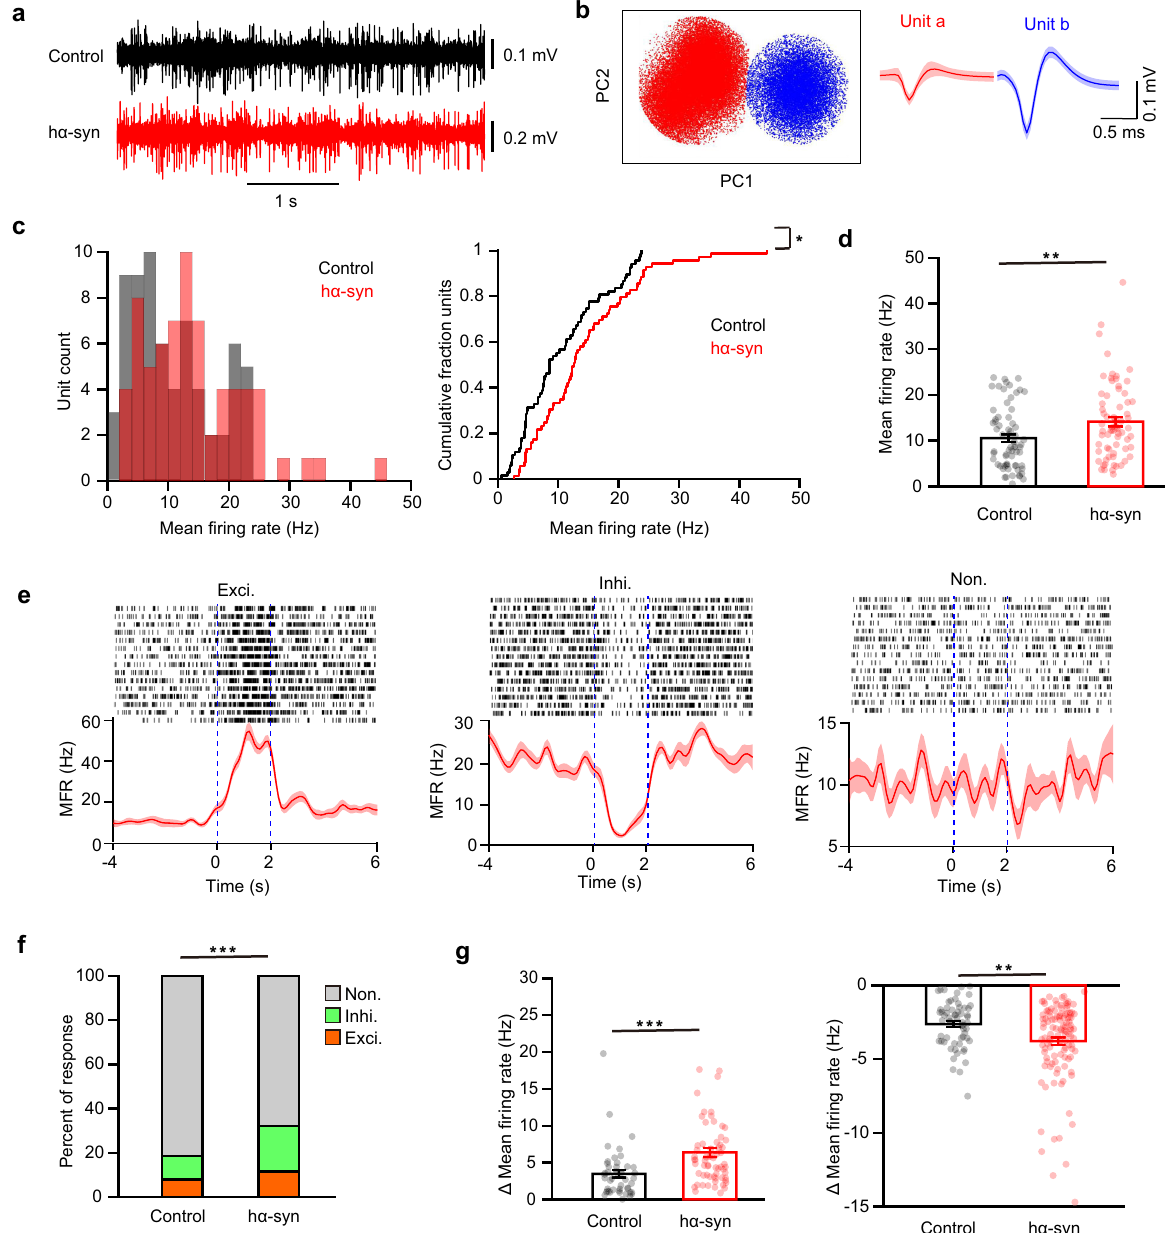
Fig. 3 Spontaneous and odor-evoked fi ring of M/Ts recorded from the OB in vivo. a Representative raw spike traces from control and h α - syn mice. b Example of spike detection and sorting using PCA clustering of extracellular microelectrode recordings, resulting in separation of two single units (unit a, red; unit b, blue). c Histogram (left) and cumulative probability (right) of the baseline mean fi ring rate (MFR) for all cells recorded. d Comparison of the spontaneous fi ring rate of M/T cells in the OB of control and h α -syn mice. e Three examples of cell fi ring responses to odor presentation. From left to right: an excitatory response, an inhibitory response, and no response. Dotted blue lines indicate the onset and offset of odor presentation. f Stacked bar plots showing the percentage of odor-evoked M/T responses in control ( n = 8) and h α -syn ( n = 10) mice. g Quanti fi cation of the change in fi ring rate of odor-evoked excitatory (left: n = 45 and n = 64 unit – odor pairs for the control and h α -syn groups, respectively) and inhibitory (right: n = 60 and n = 113 unit – odor pairs for the control and h α -syn groups, respectively) responses in the two groups. * p < 0.05; ** p < 0.01; *** p < 0.001. Data are presented as mean ±